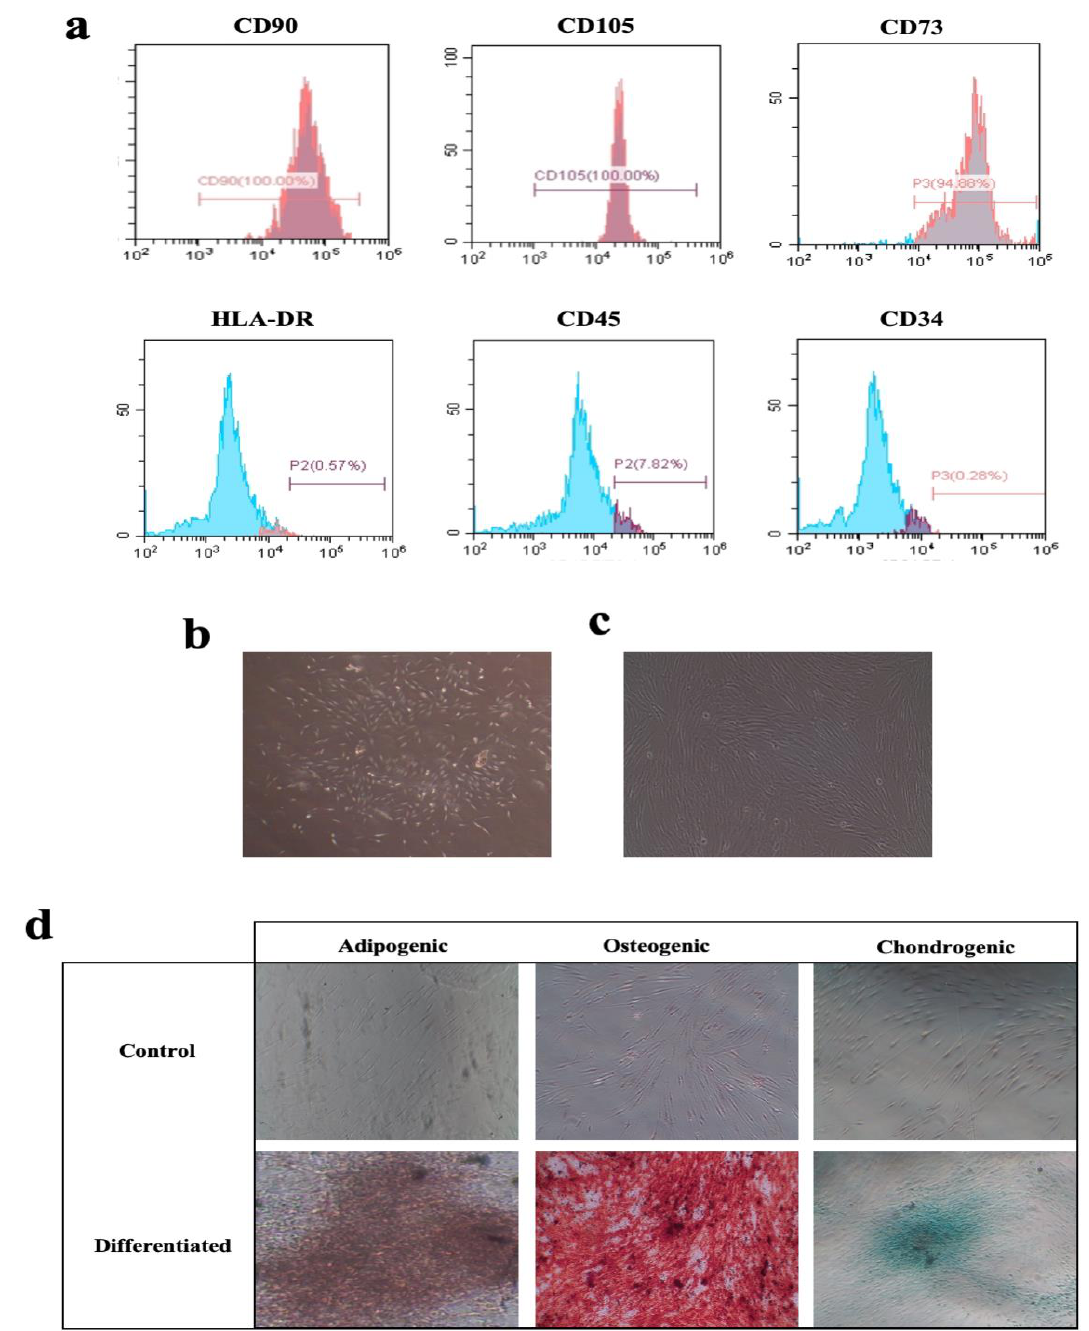
Figure 1. ( a ). Flowcytometry analysis showing that 100% of the hPDLSCs were CD105-positive, 100% CD90-positive, and 94.88% were CD73-positive, respectively, while only 7.82% of the hPDLSCs were CD45-positive, 0.28% were CD34-positive, and 0.57% were HLA-DR-positive. ( b ). Clone formation at around 5 days of culture ( × 40 original magnification). ( c ). Spindle cell morphology of hPDLSCs ( × 100 original magnification). ( d ). Oil Red O staining after adipogenic differentiation, Alizarin Red S (ARS) staining after osteogenic differentiation, and Alcian Blue staining after chondrogenic differentiation ( × 40 original